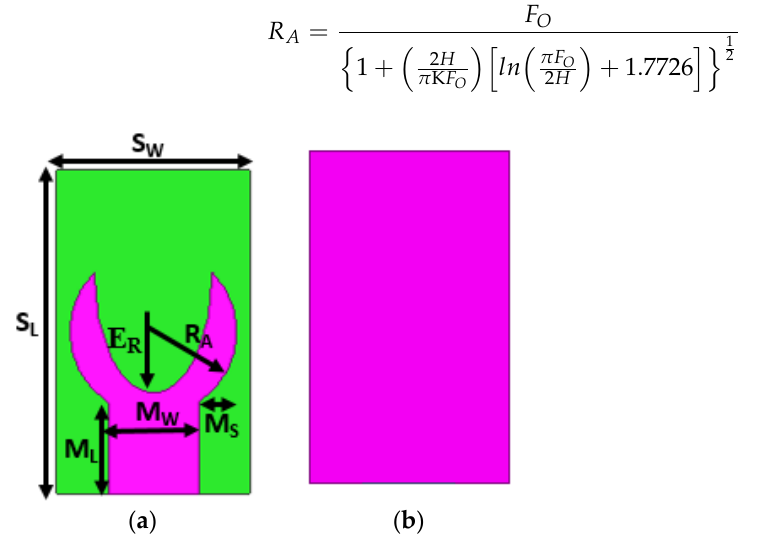
Table 1. Geometrical dimensions of the proposed antenna (mm).